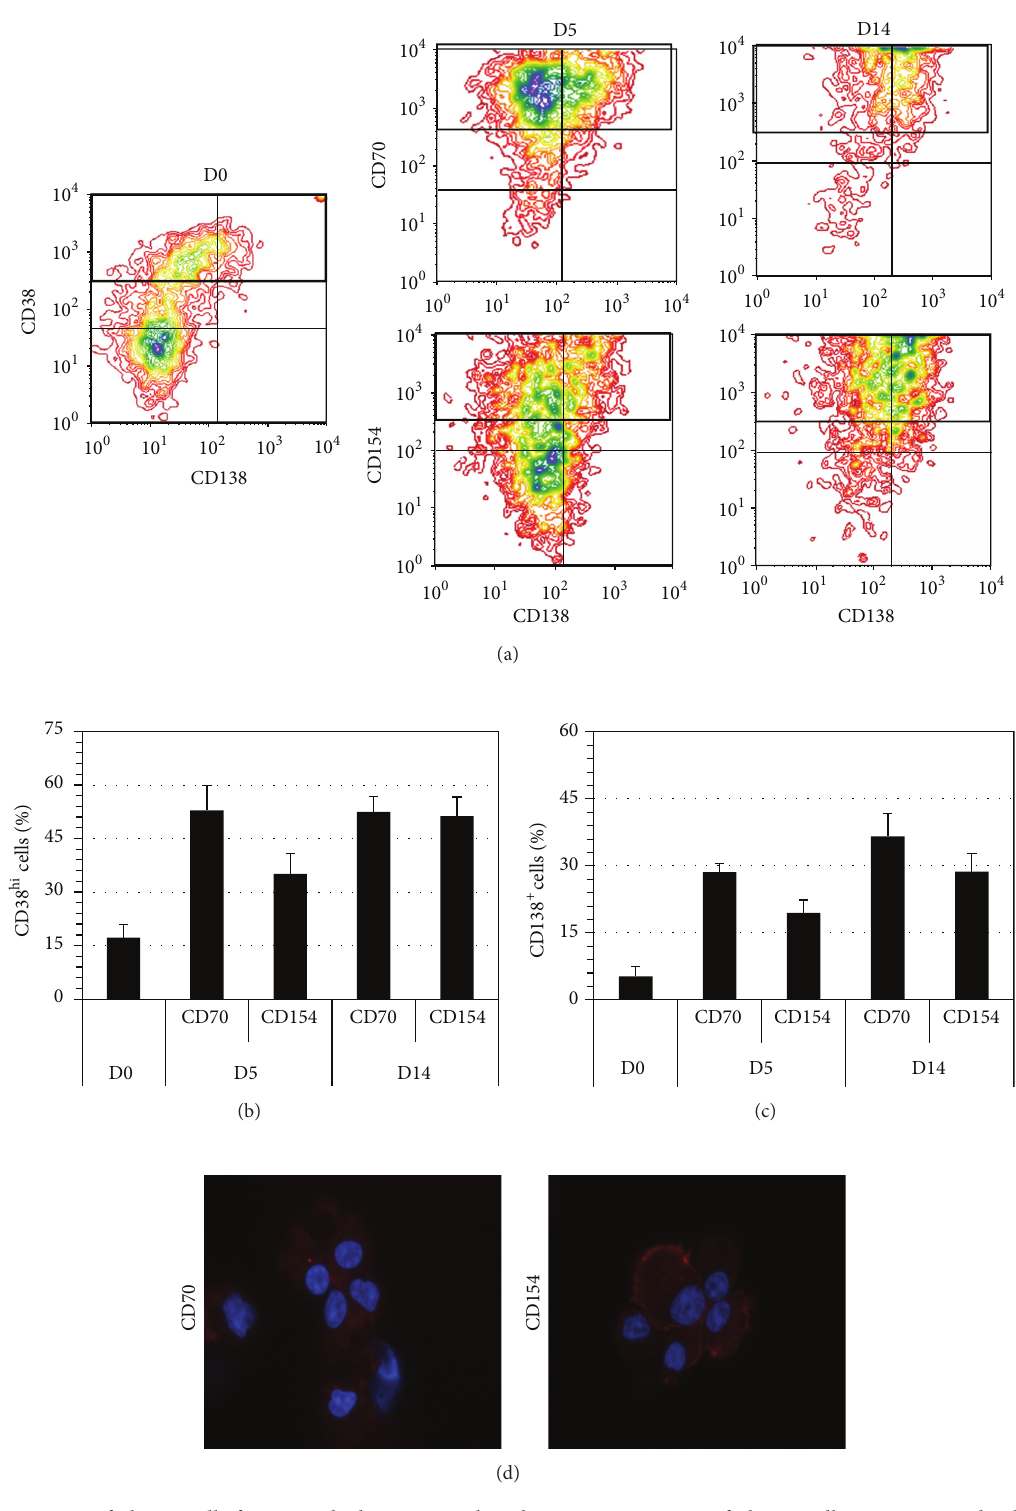
Figure 3: Generation of plasma cells from switched-memory B lymphocytes. Monitoring of plasma cell generation in the differentiation phase was done by flow cytometry and all analyses were done on viable cell populations. The results are presented as the mean ± S.E.M. of 6 independent samples: (a) CD38 and CD138 expression profiles on D0, 5 and 14. D0 being the day that the expanded memory B cells were thawed and were put in culture with CD70 + or CD154 + cell lines. (b) CD 38 hi cells frequency. The comparison of CD 38 hi cells frequency at D5 was determined using a Mann-Whitney test, 𝑃 value = 0.0260. For the monitoring of CD138 + cells frequency (c), the Kruskal-Wallis test was used and no significant difference was observed. (d) Generated plasma cells morphology at D14 shown by fluorescence microscopy (100x immersion oil objective). Blue: nucleus; red: actin. Representative cells are